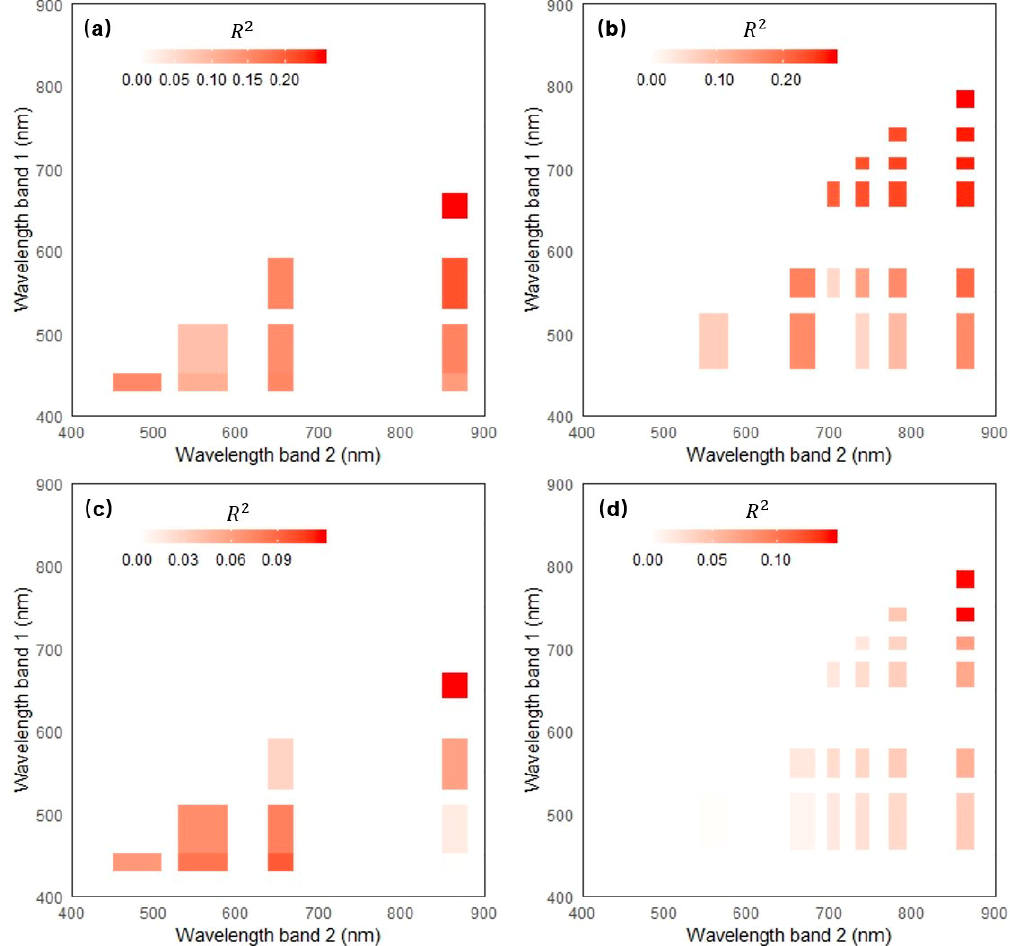
Figure 10. Correlograms depicting R 2 values (red color) of linear regressions between CI-based band combinations computed by the value of reflectance at x- and y-axes and coverage of BSCs using: ( a ) simulated multispectral data of Landsat-8 channel; ( b ) simulated multispectral data of Sentinel-2 channel; ( c ) Landsat-8 images; and ( d ) Sentinel-2 images.